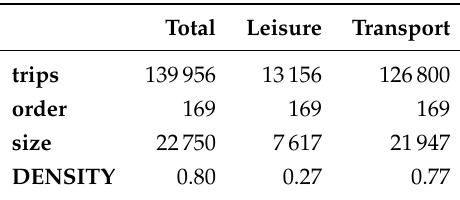
Table 4. Comparison of